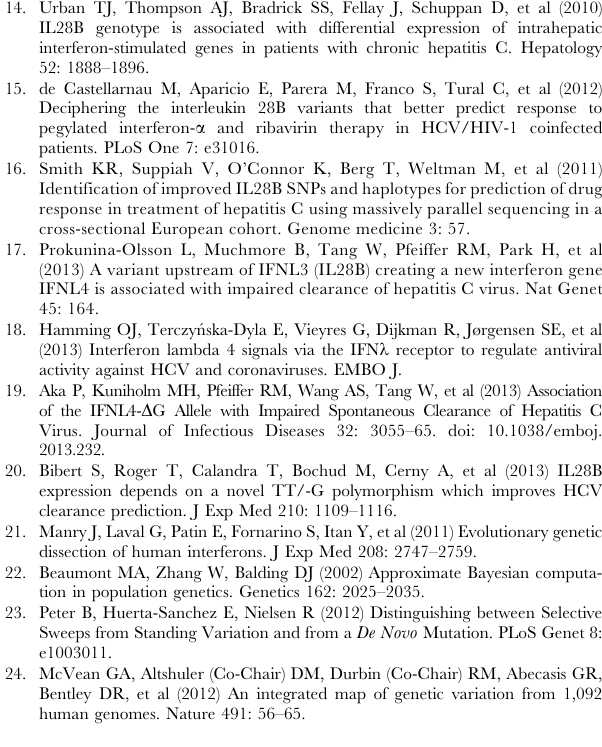
Table S4 Empirical P-values for the XP-EHH analysis for continental comparison. Table S5 Diversity associated with the TT haplotype in each population, as measured with Watterson’s estimator and using only TT/TT homozygous individuals. (PDF) Table S6 ABC results and inferred parameter estimates for (a) the SSV model and (b) the neutral model. (PDF) Table S7 Tajima’s D (TD), HKA, and MWUhigh results. (PDF) Table S8 IFNL4 orthologous exons retrieved through BLAT search with human reference IFNL4 - D G (for primate species) and the panda ortholog (for non-primate